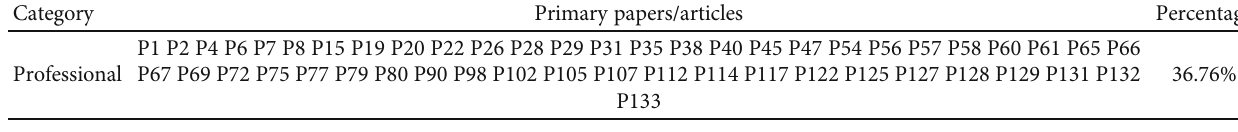
Table 10: Application contexts.